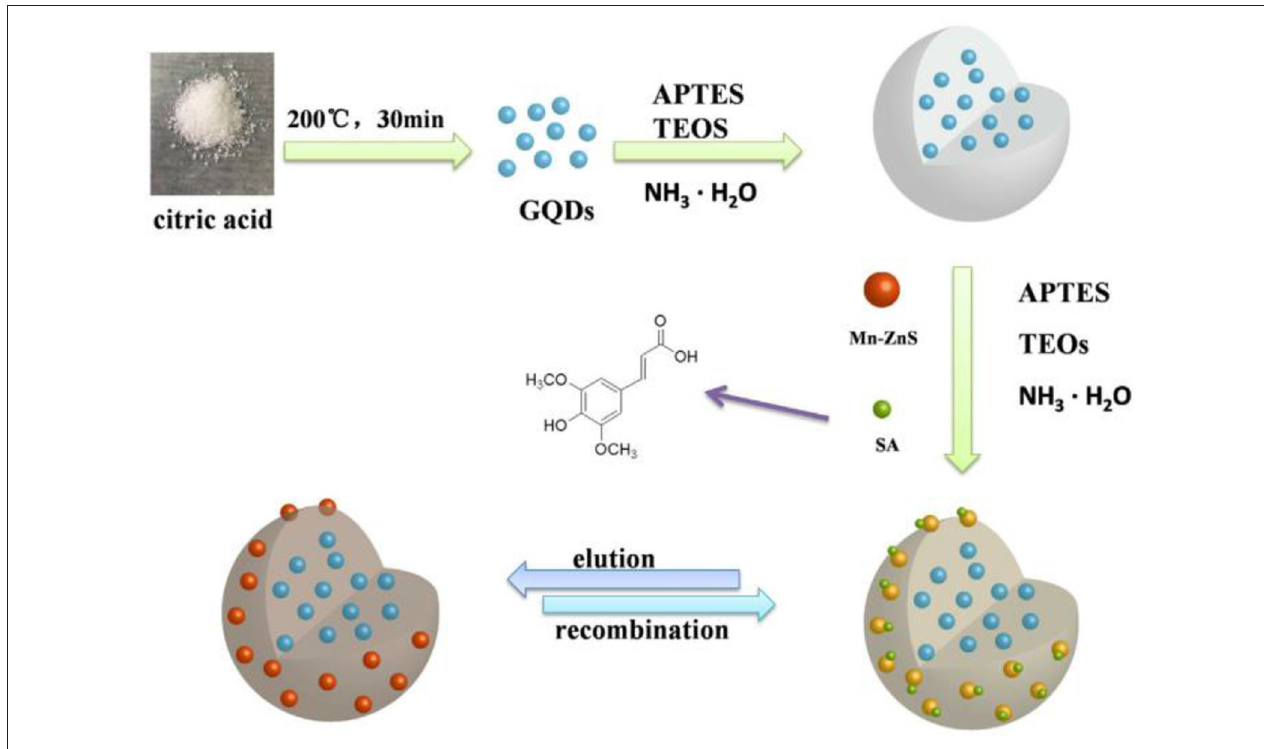
FIGURE 7 | Schematic illustration for the preparation of the ratiometric fluorescence sensors based on MIPs@Mn-ZnS/GQDs@SiO 2 and for the SA detection and recognition (Zhu et al., 2020). Reprinted with permission from Elsevier. Copyright (2020) Elsevier.